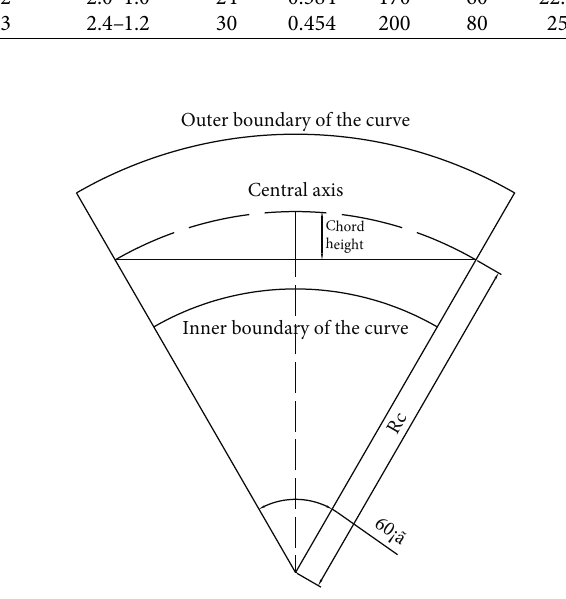
Figure 5: Geometric dimensions of the bend. Table 2: Design of orthogonal